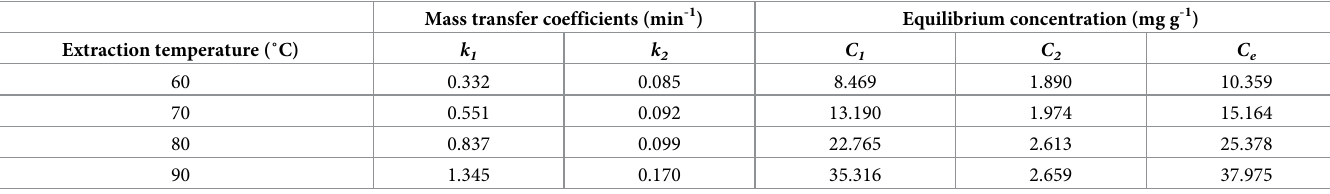
Table 3. The Patricelli kinetic model for the extracted EPA from N . oceanica microalgae using